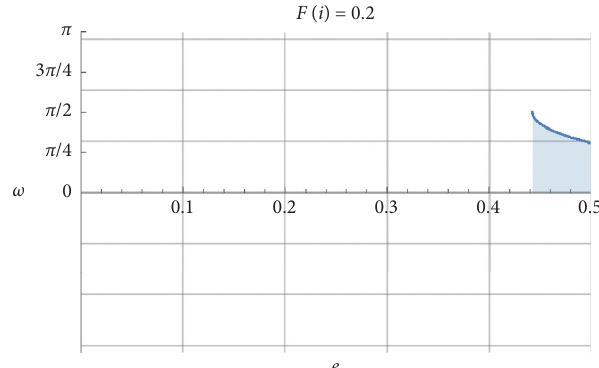
Figure 11: The curve ω ( e ) at which _ e � _ i � 0 for F ( i ) � 0.2.